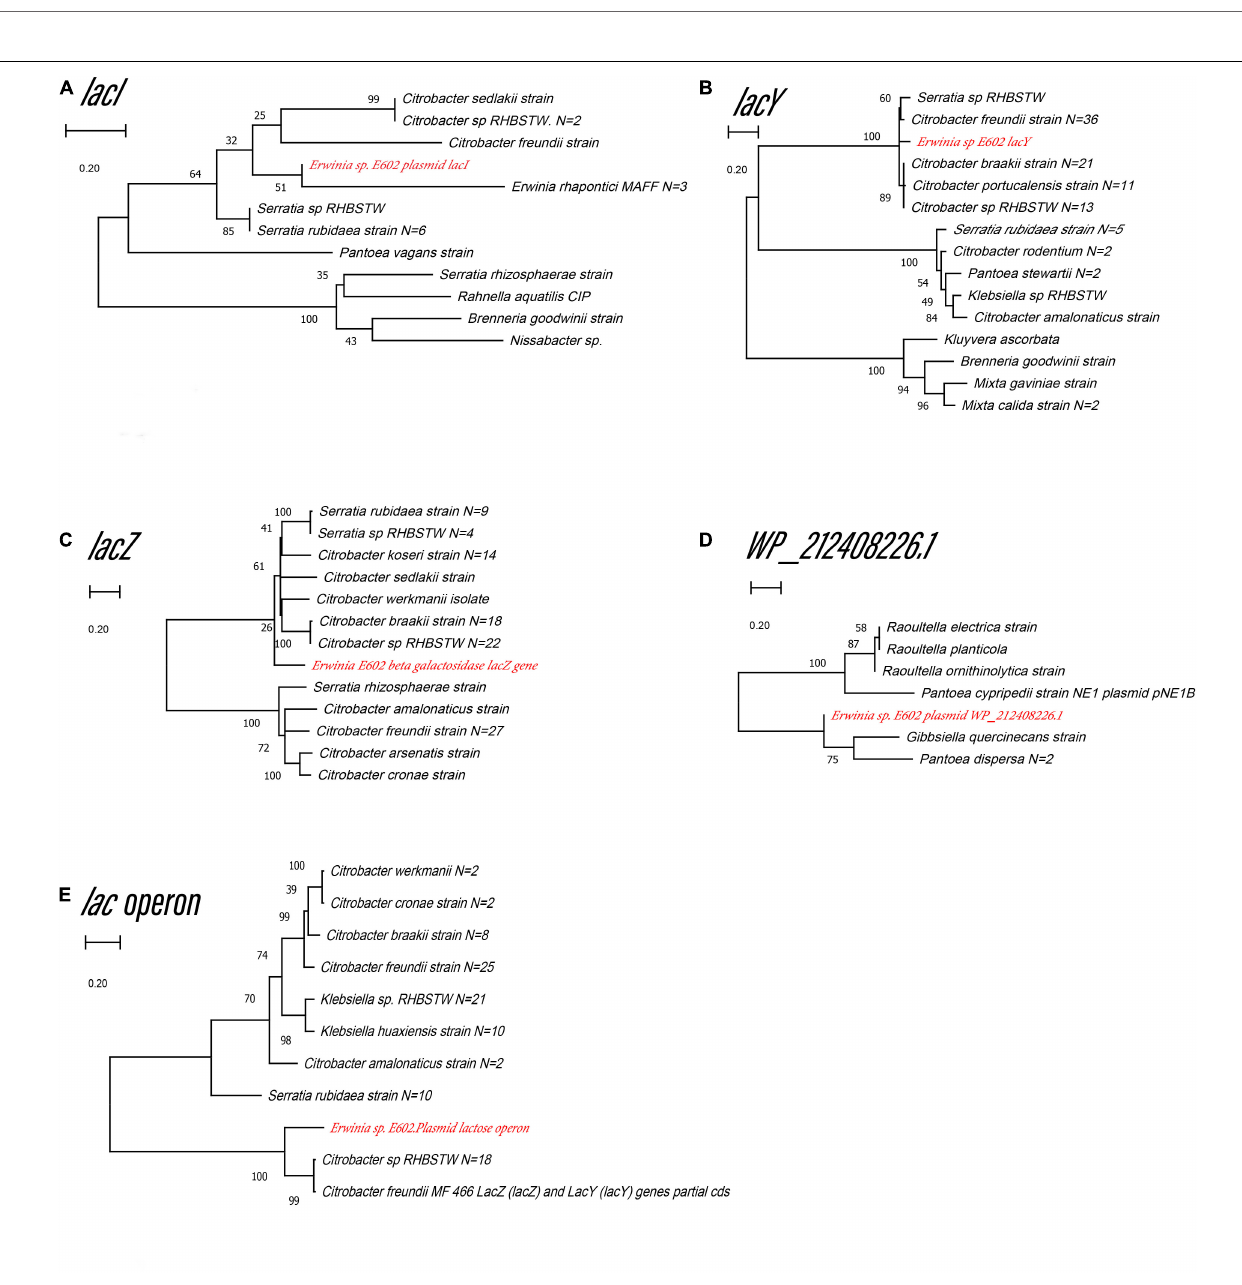
FIGURE 3 | Unrooted maximum likelihood phylogeny of the four plasmid-borne lac operon and lacI -like (WP_212408226) genes. Phylogeny trees of the genes lacI (A) , lacY (B ) , lacZ (C) , lacI -like (WP_212408226) (D) , lac operon (E) based on gene sequences. These trees were obtained using software MEGA7 by the Neighbor-Joining method. Numbers at branch nodes indicate bootstrap values of 1,000 trials (only bootstrap values above 50% were shown). Bar = 0.20 substitutions per nucleotide